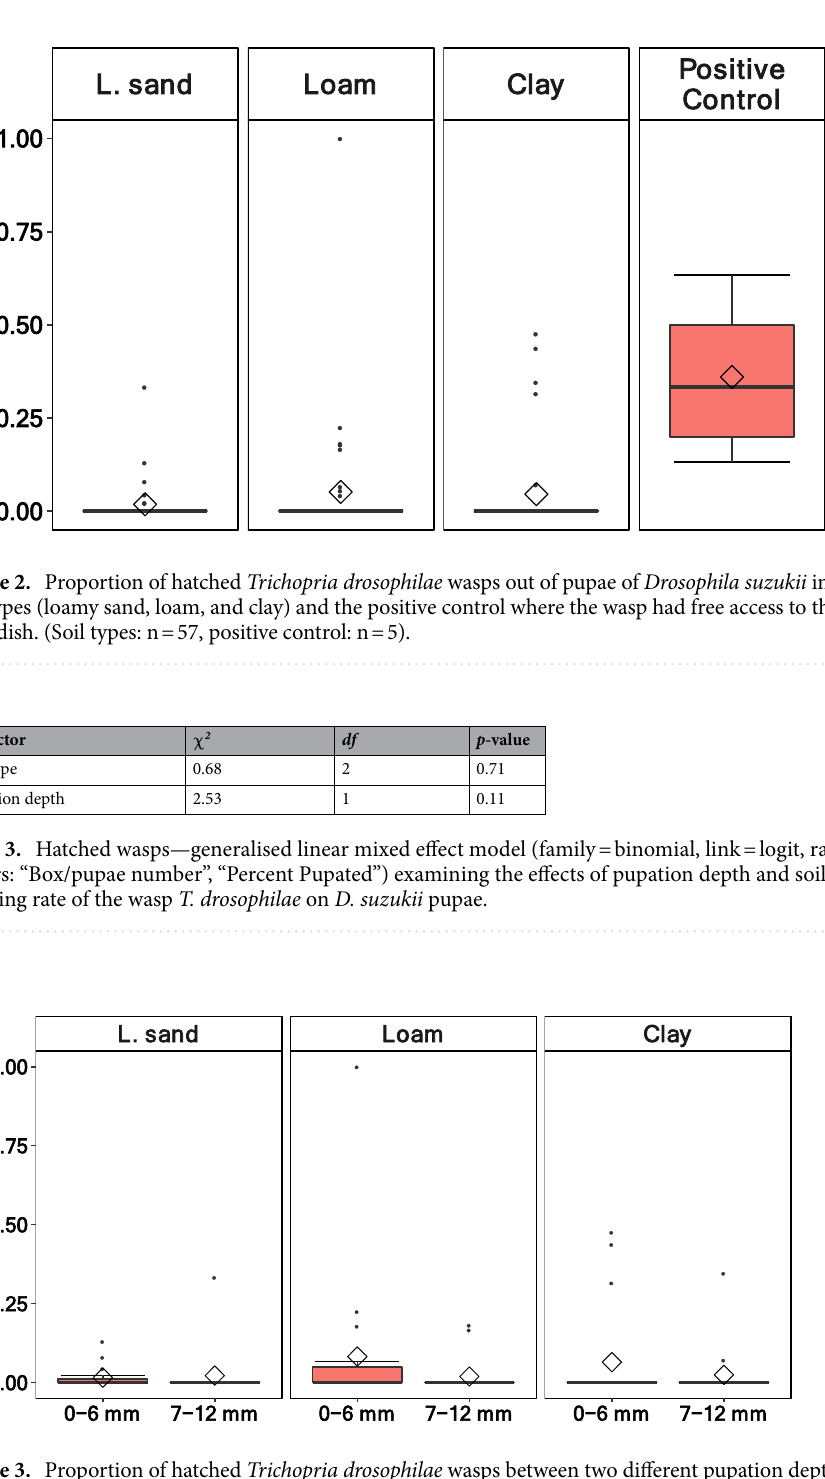
Figure 3. Proportion of hatched Trichopria drosophilae wasps between two different pupation depths (0–6 mm and 7–12 mm) in the soil types loamy sand, loam and clay (n =